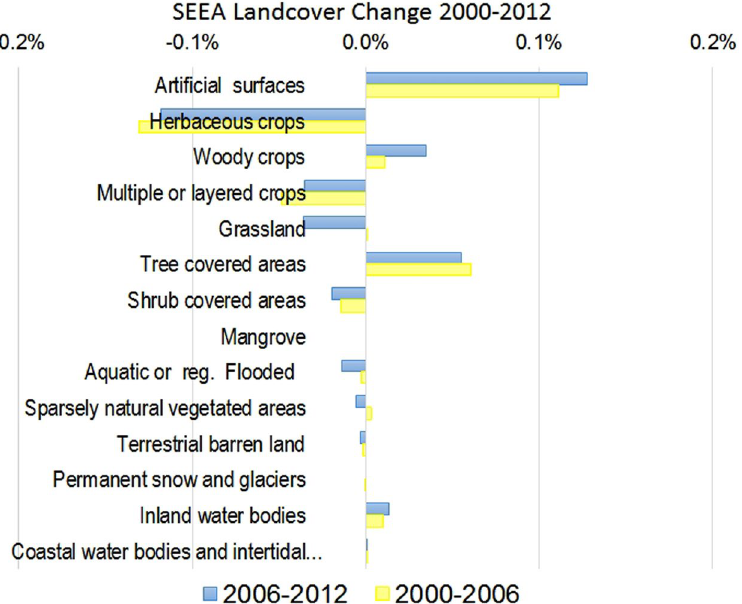
Figure 2. European land cover change according to the SEEA aggregate classes between 2000 and 2012. The % is relative to the total land cover in the EU-25